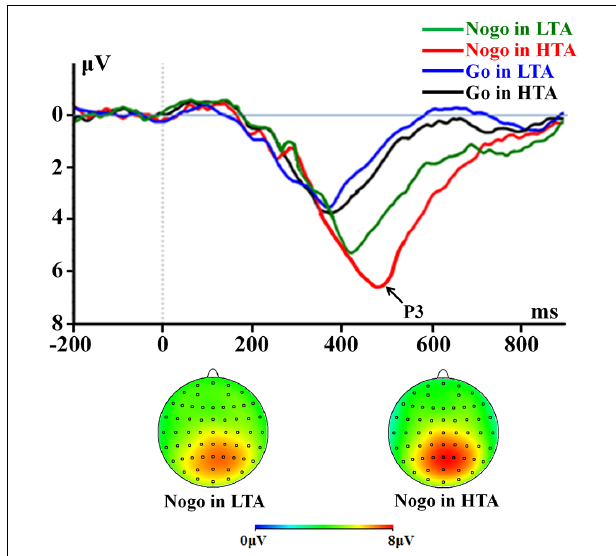
FIGURE 4 | The P3 component time-locked to the Go and NoGo conditions. ERPs were calculated by averaging the data at the electrodes of Pz, P1, P2, CPz, CP1, CP2, and